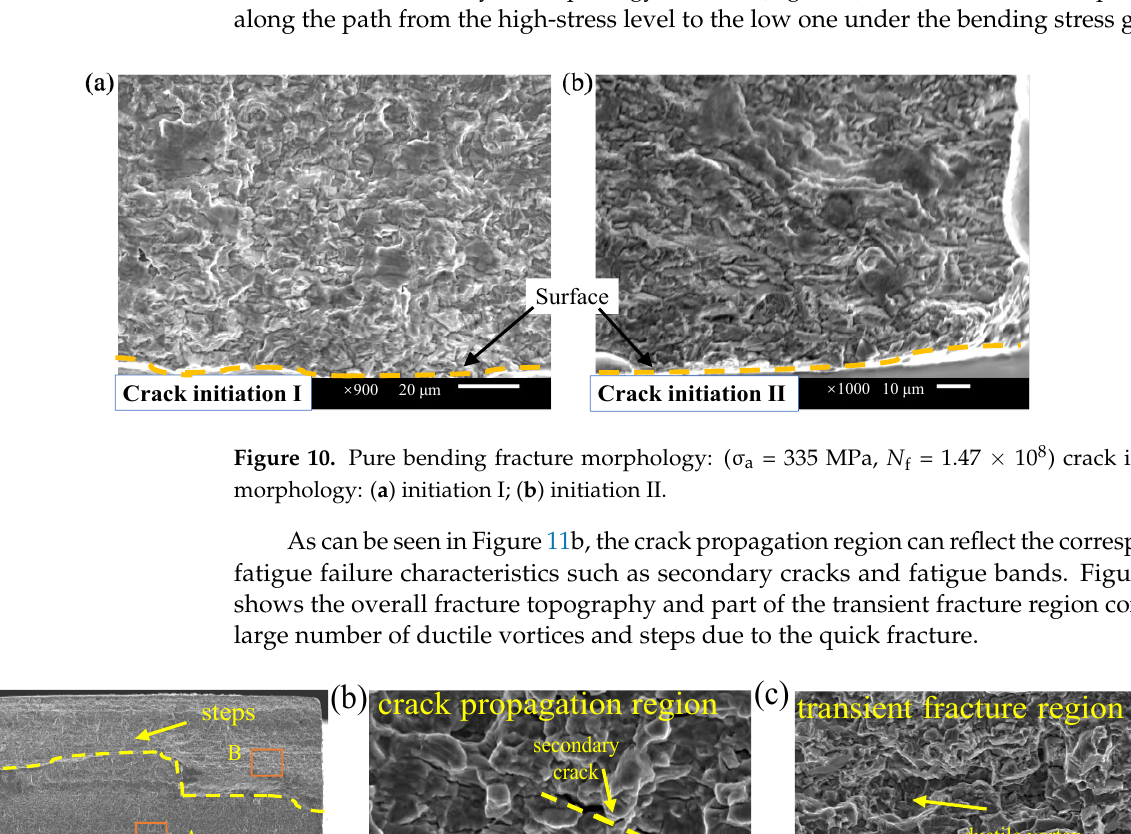
Figure 9. Pure bending fracture morphology: ( a ) σ a = 555 MPa, N f = 3.82 × 10 6 ( b ) σ a = 435 MPa, N f = 1.69 × 10 7 ; ( c ) σ a = 335 MPa, N f = 1.47 × 10 8 ; ( d ) σ a = 305 MPa, N f = 5.41 × 10 8 .